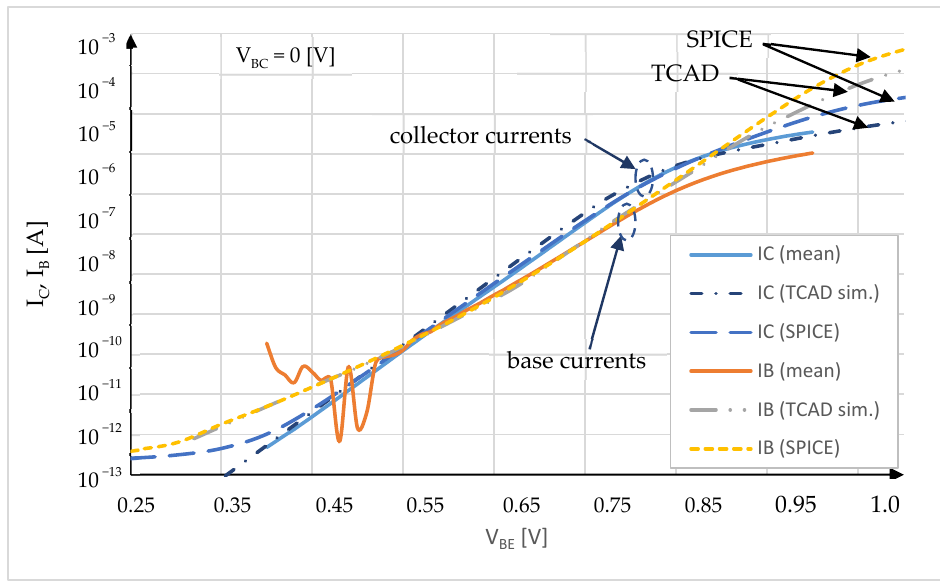
Figure 17. Comparison of measured collector and base current (solid lines) with TCAD and PSPICE simulation results. Solid lines—averaged measured results; dot-dashed lines for the TCAD simulation results; dashed lines for the SPICE model simulation results.